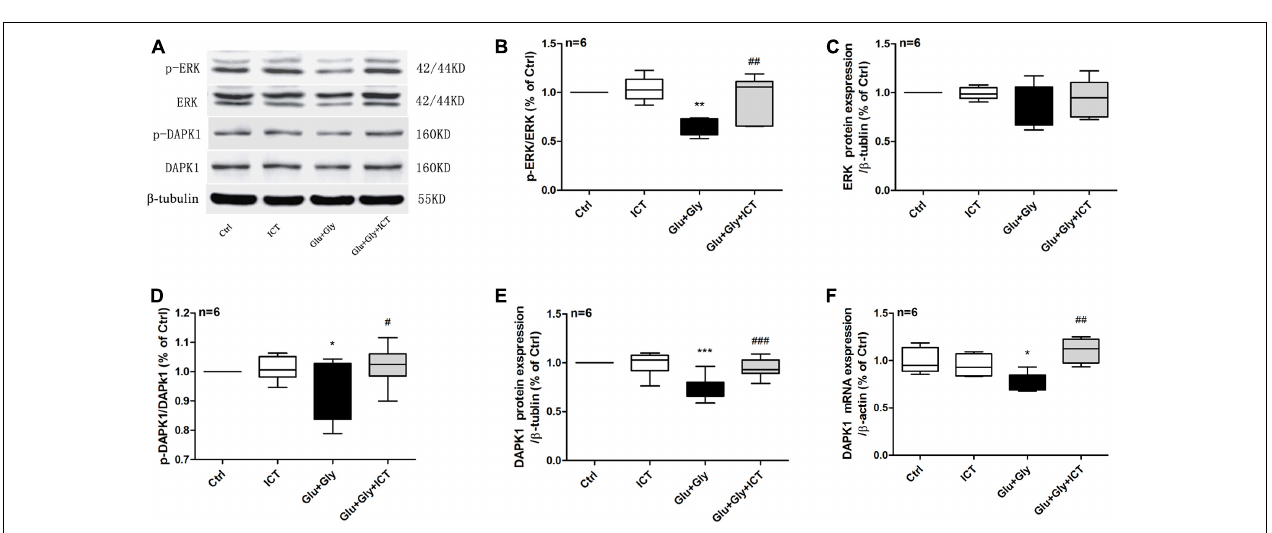
FIGURE 3 | ICT rescues the reduction in phosphorylation of ERK and DAPK1 and DAPK1 expression levels after glutamate-induced neuronal injury. Western blot and RT-qPCR were used to analyze p-ERK, ERK, p-DAPK1 and DAPK1 protein expression levels (A–E) and DAPK1 mRNA levels (F) in the four treatment groups: control, 1 µ M ICT, Glu+Gly and Glu+Gly+1 µ M ICT, and the results are expressed as the mean ± SEM ( n = 6). One-way ANOVA followed by Newman-Keuls test, (B) : F = 8.998, (C) : F = 1.295, (D) : F = 3.283, (E) : F = 13.22, (F) : F = 8.403; * p < 0.05, ** p < 0.01, and *** p < 0.001 vs. control; # p < 0.05, ## p < 0.01, and ### p < 0.001 vs.